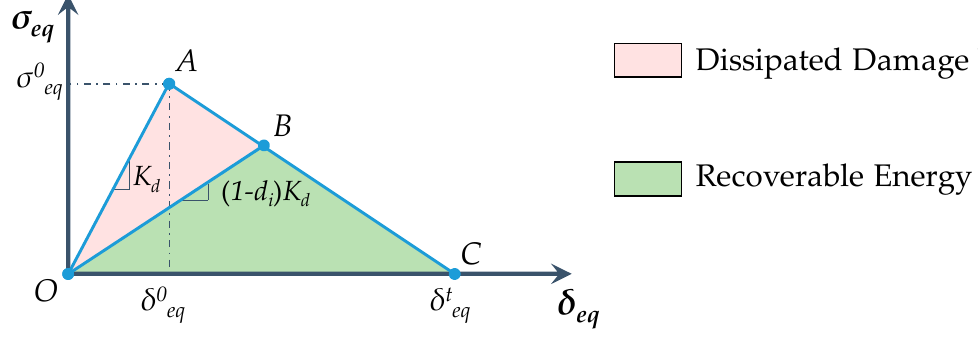
Figure 1. Constitutive relation (damage evolution).